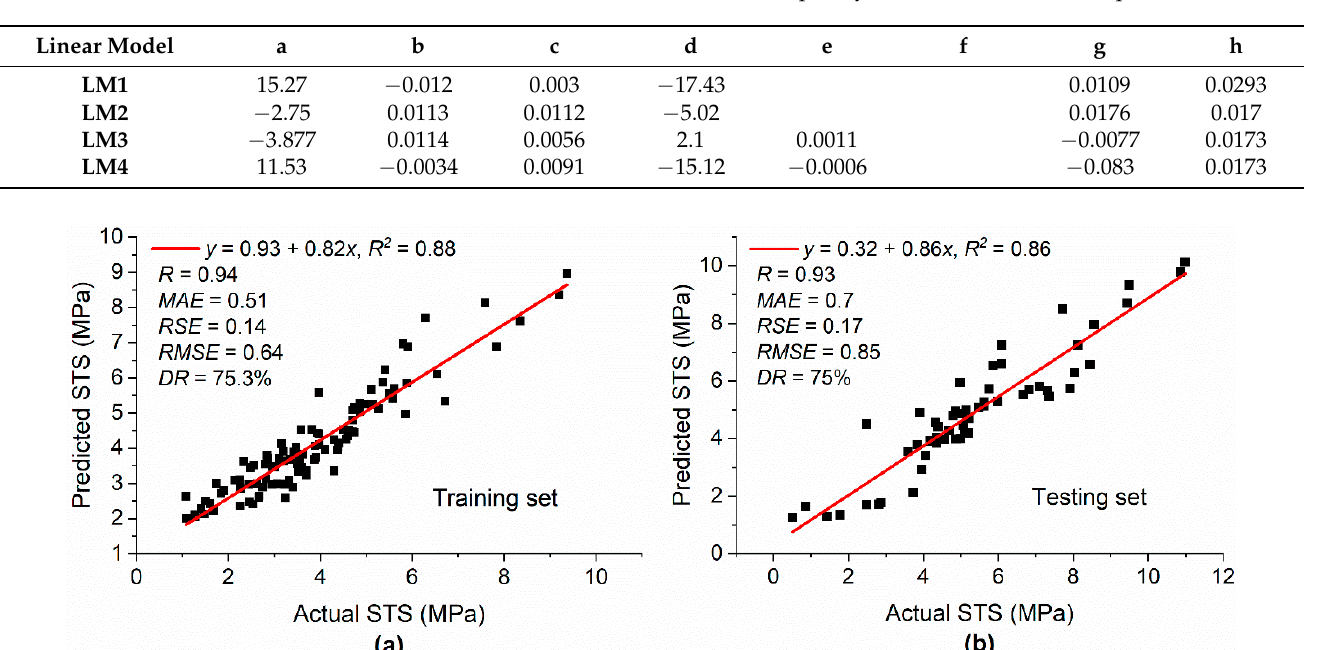
Table 5. Coefficients of the linear models developed by M5P for STS based on Equation (4).